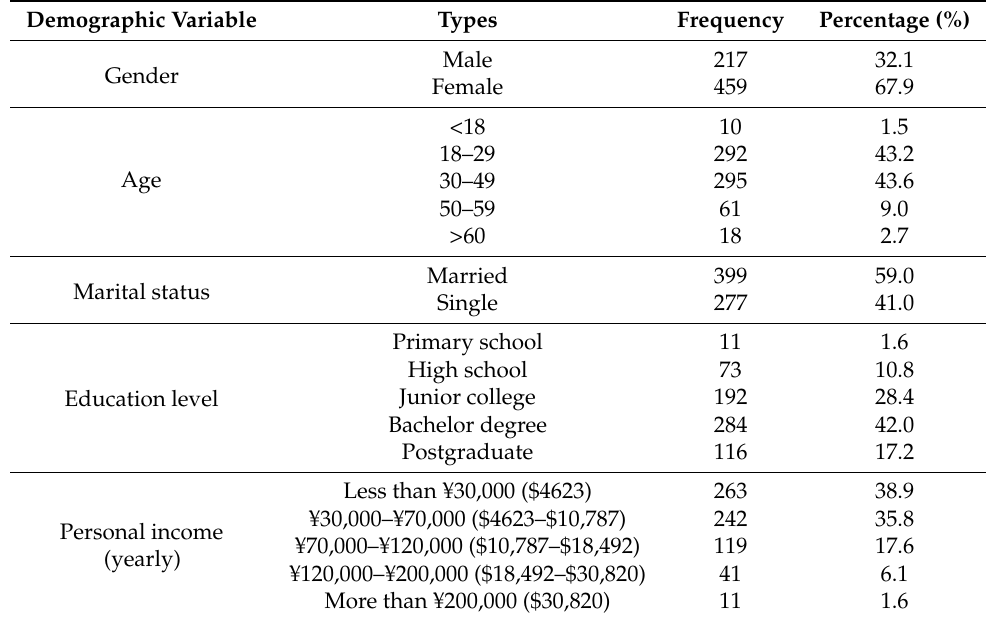
Table 2. Demographic characteristics of the sample ( n =